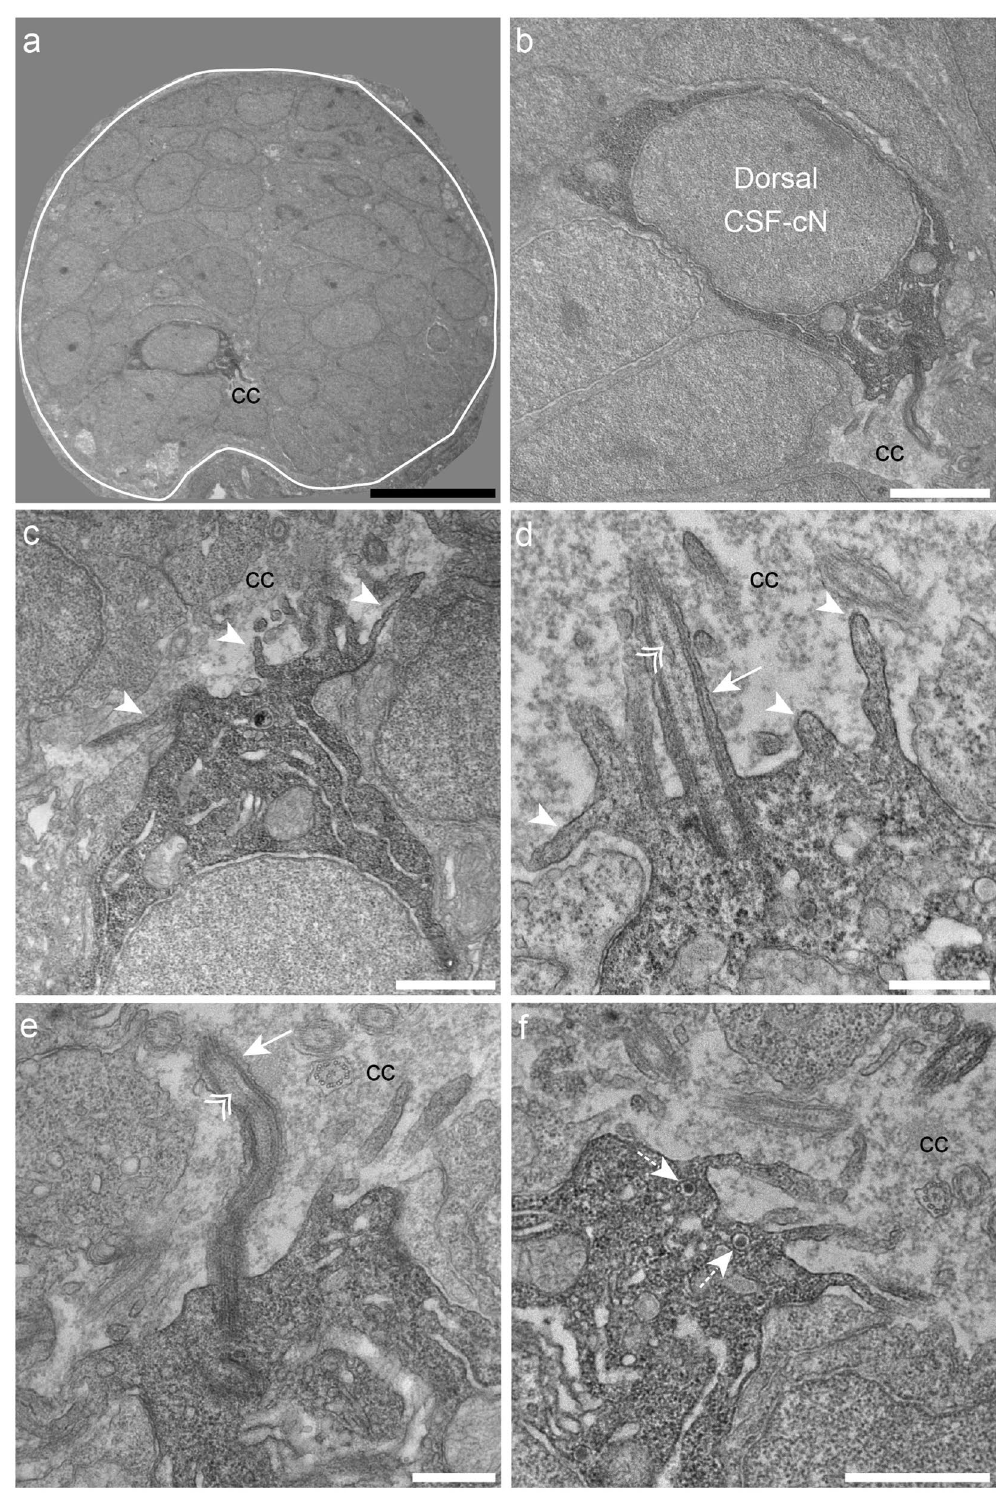
Figure 2. Dorsal spinal CSF-cNs also exhibit ultrastructural properties of sensory neurons. ( a ) Transverse section of the spinal cord showing restricted deposition of DAB in a dorsal CSF-cN. ( b ) Overall view of a DAB + dorsal CSF-cN contacting the central canal (cc). ( c , d ) Dorsal CSF-cNs bear at the apical pole multiple microvilli (arrowheads). ( d , e ) In the apical pole is located a cilium (arrow) with two central microtubule singlets along the axoneme (double arrowhead), reminiscent of a motile cilium. ( f ) Dorsal CSF-cN also exhibit LGV distributed in the cytoplasm (dotted arrows). Scale bar = 10 μ m ( a ), 2 μ m ( b ), 1 µ m ( c , f ) and 500 nm ( d , e